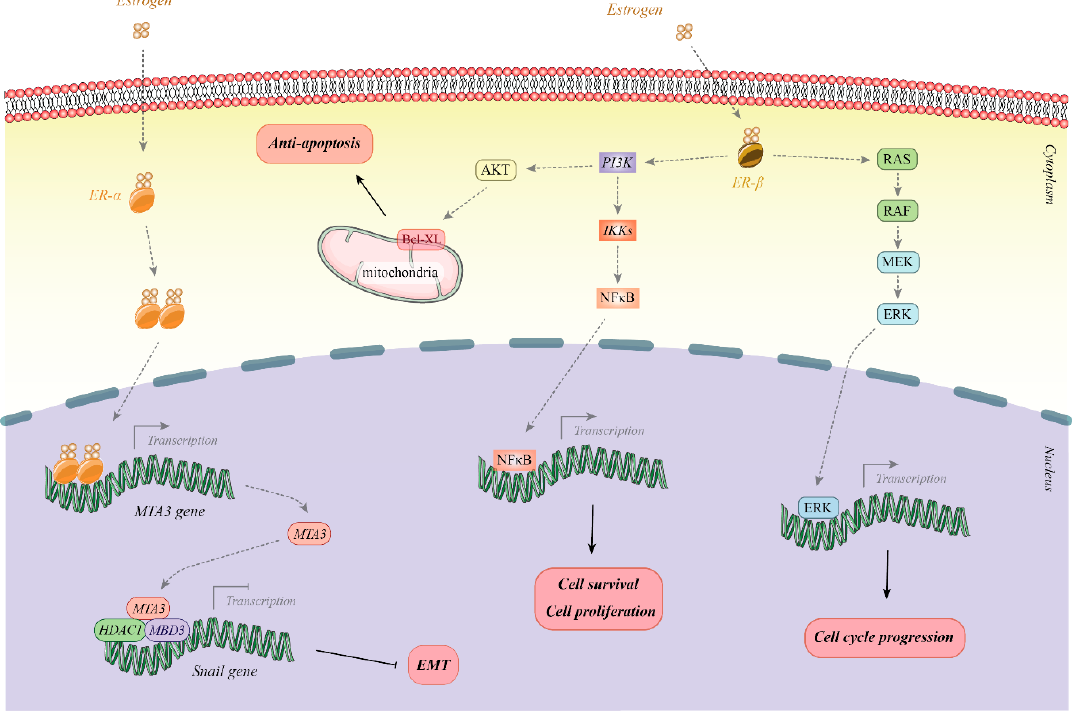
Figure 1. Overview of the estrogen receptor pathway and its key functions. Estrogen can bind with estrogen receptor (ER α or ER β ) to influence expression and activity of several signaling pathways that regulate cell cycle progression, cell survival and proliferation and epithelial–mesenchymal transition (EMT).